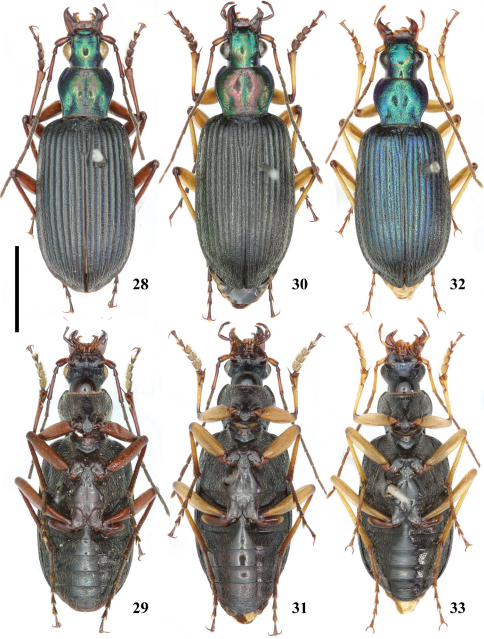
Chlaenius (Lithochlaenius) spp28 Chlaenius noguchii Bates, male, in IZCAS, dorsal view29 Chlaenius noguchii Bates, male, in IZCAS, ventral view30Chlaenius wrasei Kirschenhofer, male, in IZCAS, dorsal view31 Chlaenius wrasei Kirschenhofer, male, in IZCAS, ventral view32 Chlaenius agiloides Jedlička, male, in IZCAS, dorsal view33 Chlaenius agiloides Jedlička, male, in IZCAS, ventral view. Scale line = 5.0 mm.